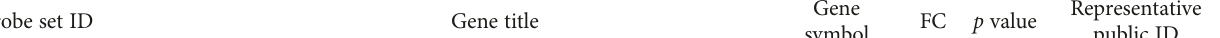
Table 2: Annotated genes di ff erentially expressed in BD PBC versus healthy controls grouped according to their